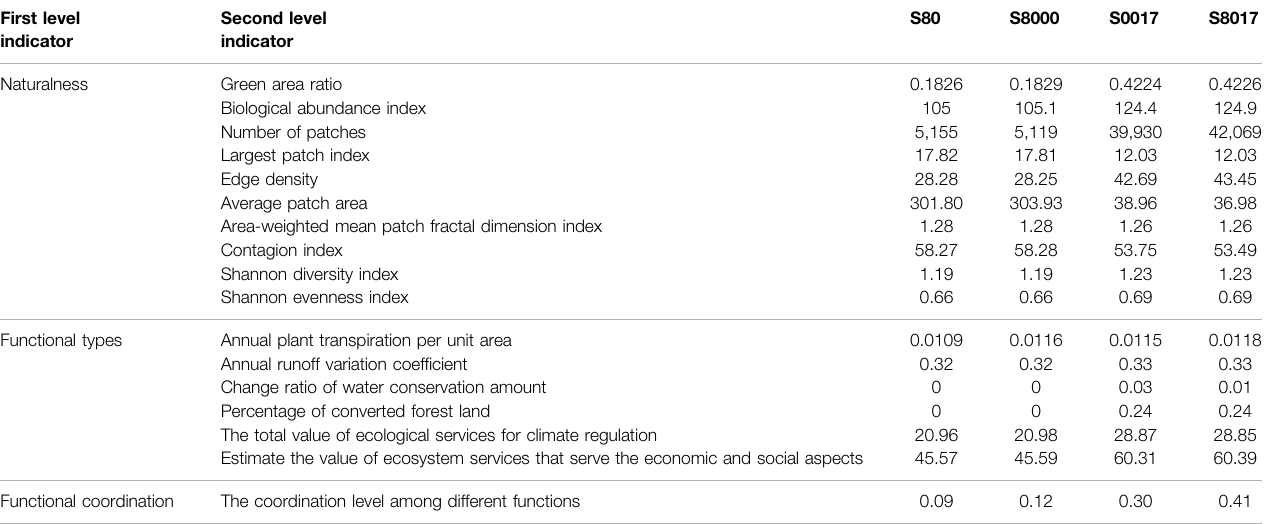
TABLE 5 | Results of secondary evaluation indicators for slope ecological restoration at different construction stages. First level indicator